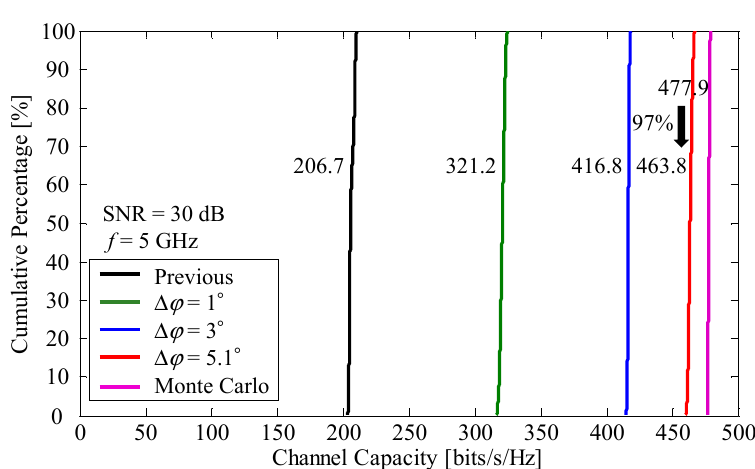
Figure 8. CDF characteristics of a system with 64 × 64 MIMO channel capacity.